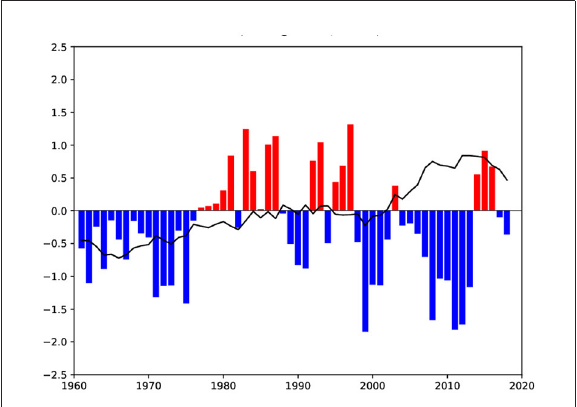
FIGURE8 Time series of PDO indices (the black line is the normalized summer precipitation index).